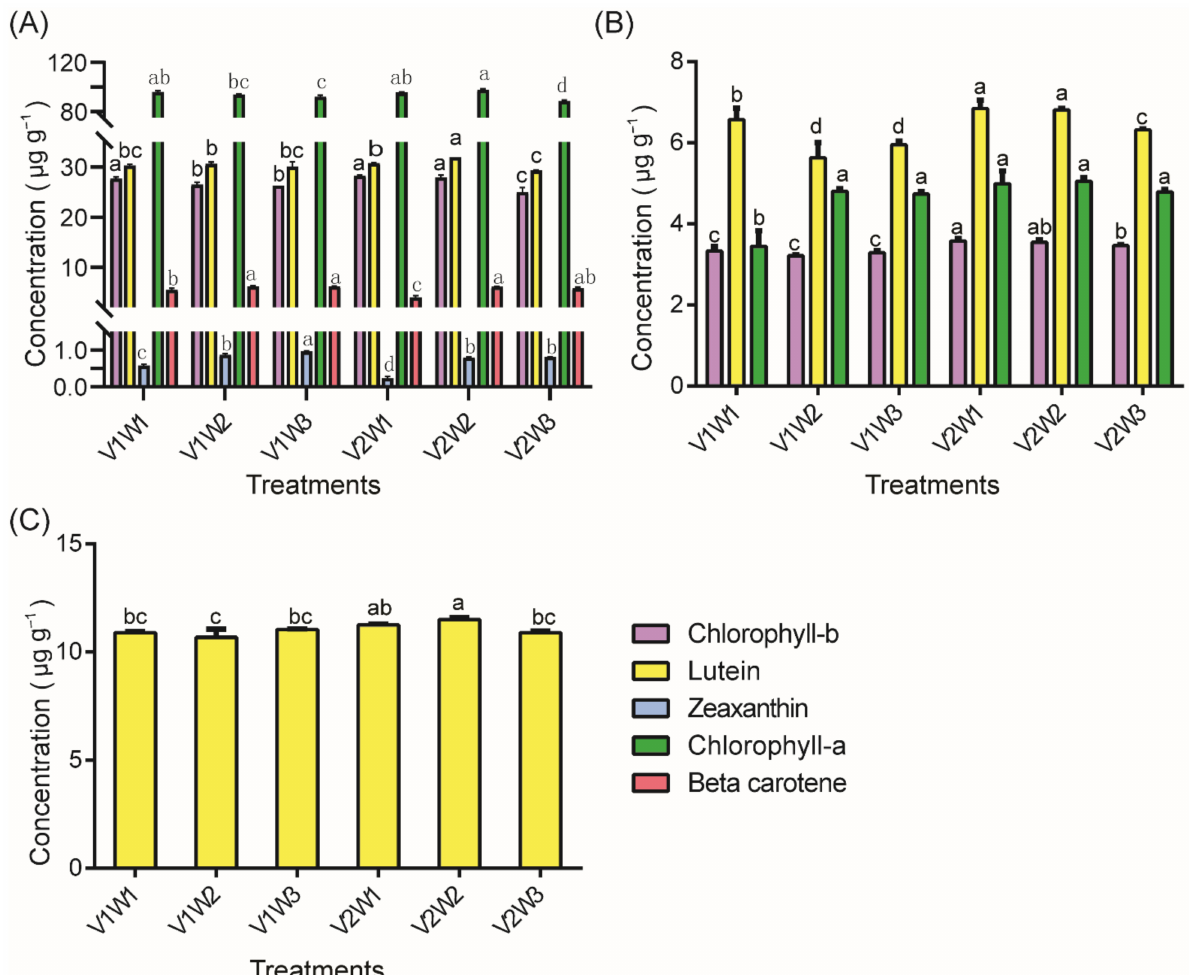
Figure 2. Effect of flour sample weight and extractant volume on the content of carotenoid and chlorophyll components. ( A ) ZDD20340; ( B ) Nanhuizao; ( C ) ZDD18672. V = volume; W = weight; V1 = 1.00 mL; V2 = 1.50 mL; W1 = 50.00 mg; W2 = 100.00 mg; W3 = 150.00 mg; Different lowercase letters at the top of each bar graph with the same color show statistically significant differences among treatments ( p <